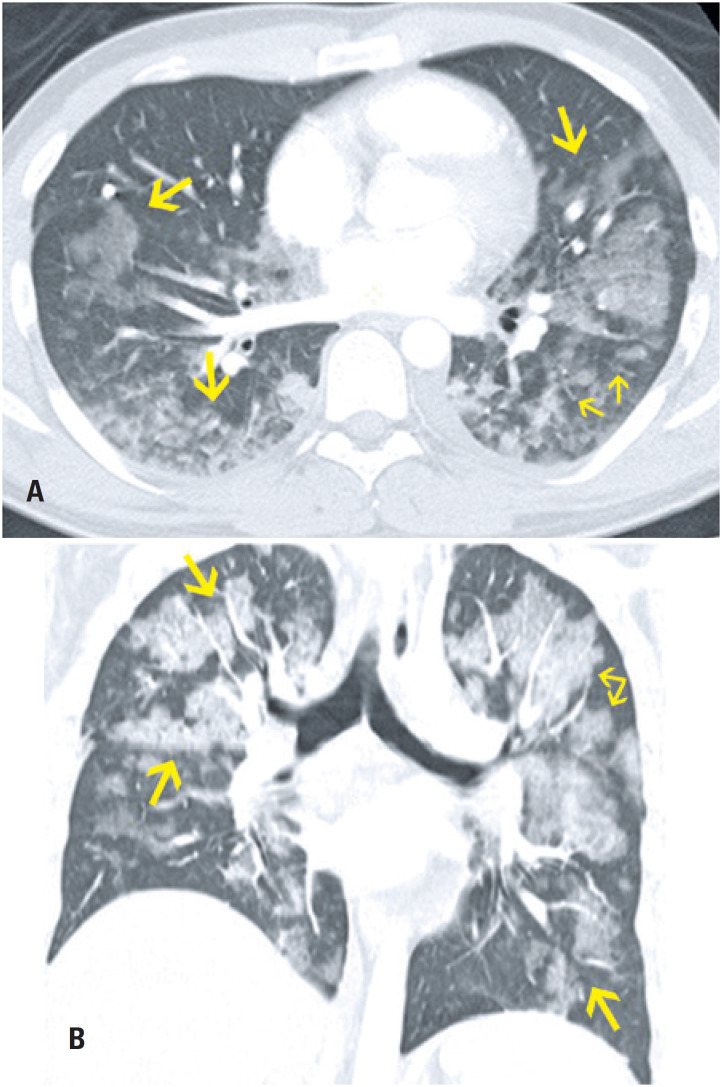
Homem, 26 anos, com queixa de dispneia súbita após correção cirúrgica de fratura da tíbia com uso de fixador externo. Tomografia computadorizada (A) Com corte axial (B) Reformatação coronal: extensas opacidades em vidro fosco e consolidações alveolares confluentes predominando na região central de ambos os pulmões, compatíveis com embolia gordurosa no contexto clínico